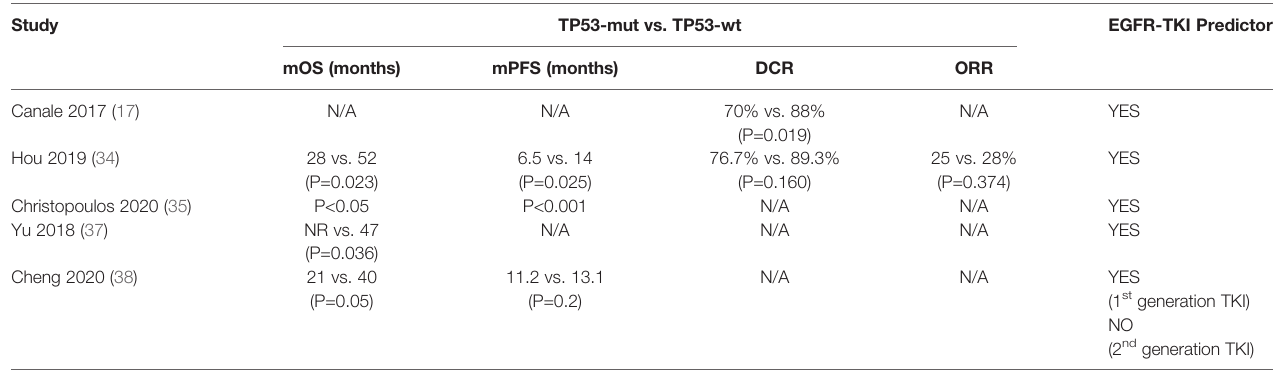
TABLE 1 | TP53 co-mutation as a poor prognostic factor in EGFR-mutated NSCLC patients.